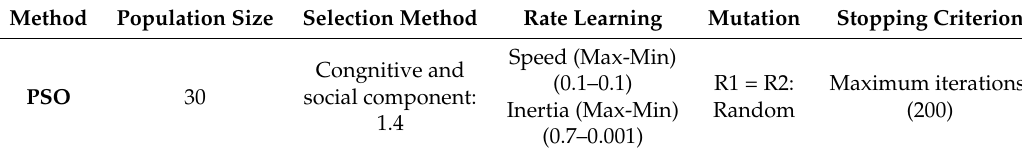
Table 2. Parameters of the sizing